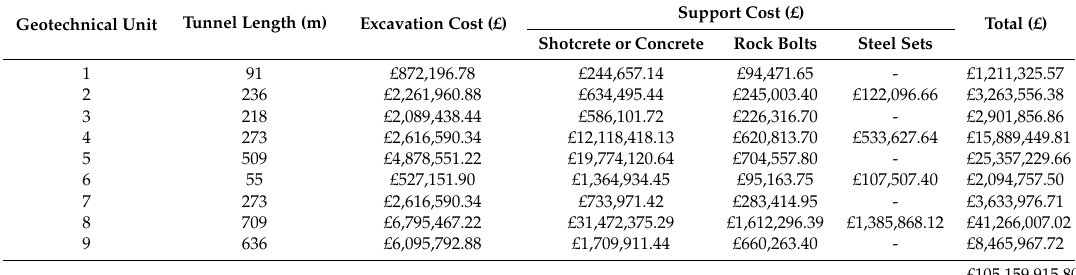
Table 11. Estimated excavation and temporary support measures cost for each Geotechnical Unit. Geotechnical